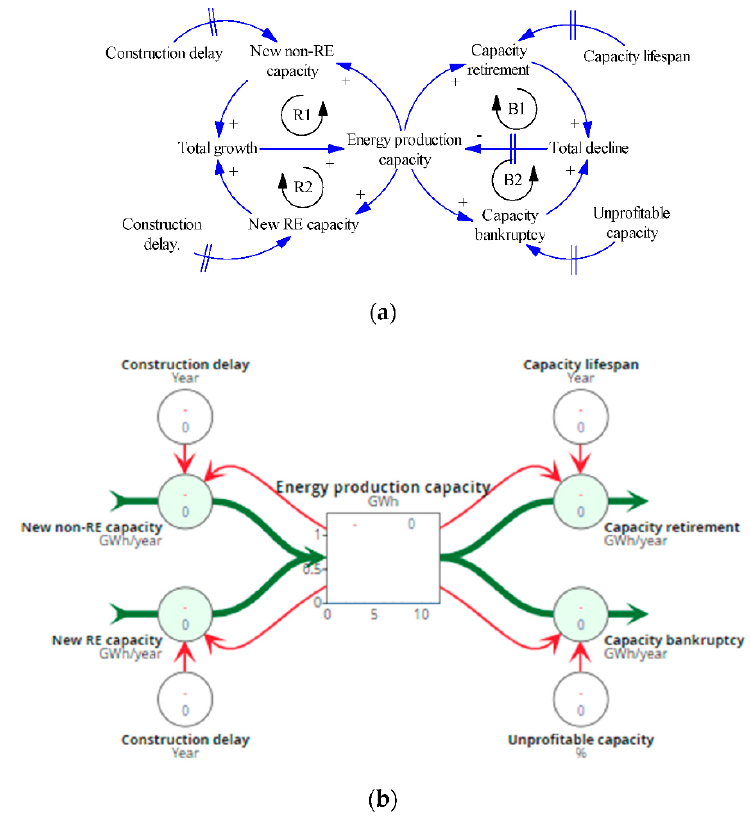
Figure 4. Feedback loops ( a ) and stock-flow model ( b ) [37].